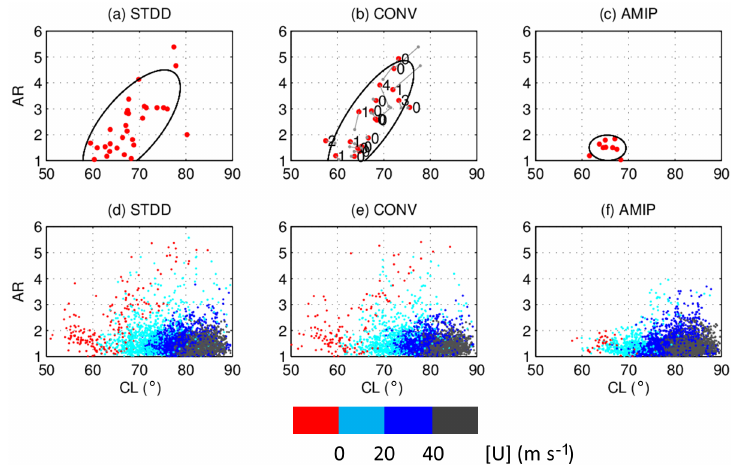
Figure 5. (a–c) Scatter plots between CL and AR of the 10hPa height on the onset dates of the NH MSSWs: (a) STDD, (b) CONV, and (c) AMIP. Ellipses denote representative distributions of the data points extracted by an empirical orthogonal function analysis. Each data point in (b) is connected to the corresponding case in STDD (gray) and accompanied by a number denoting the time difference in the onset dates (Table 1). Panels (d–f) plot results for all DJF days available to each product. Each data point is colored by the zonal mean zonal wind at 60 ◦ N, 10hPa (see the color